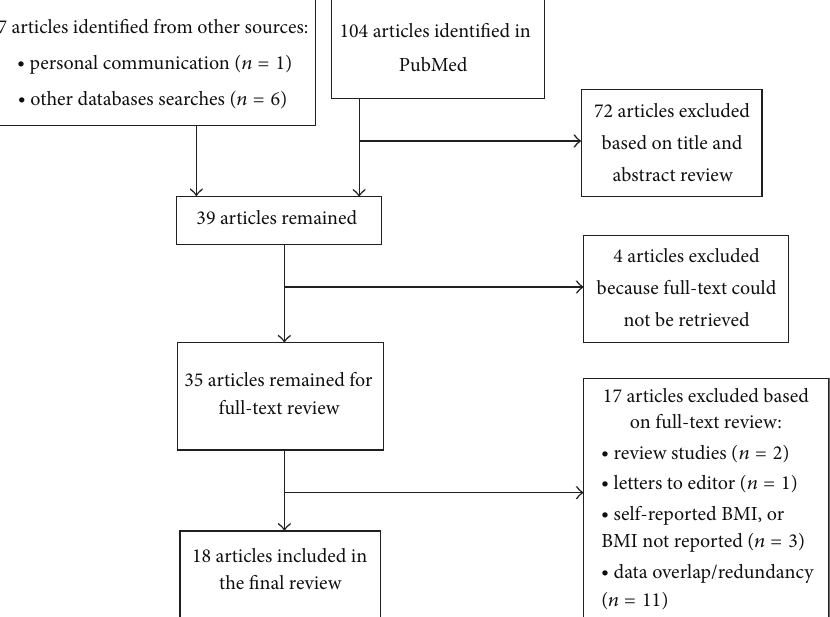
Figure 2: Flow chart for articles identification and